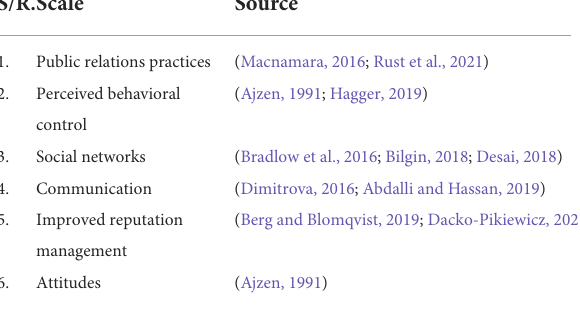
TABLE 1 Source of scales used in the questionnaire.